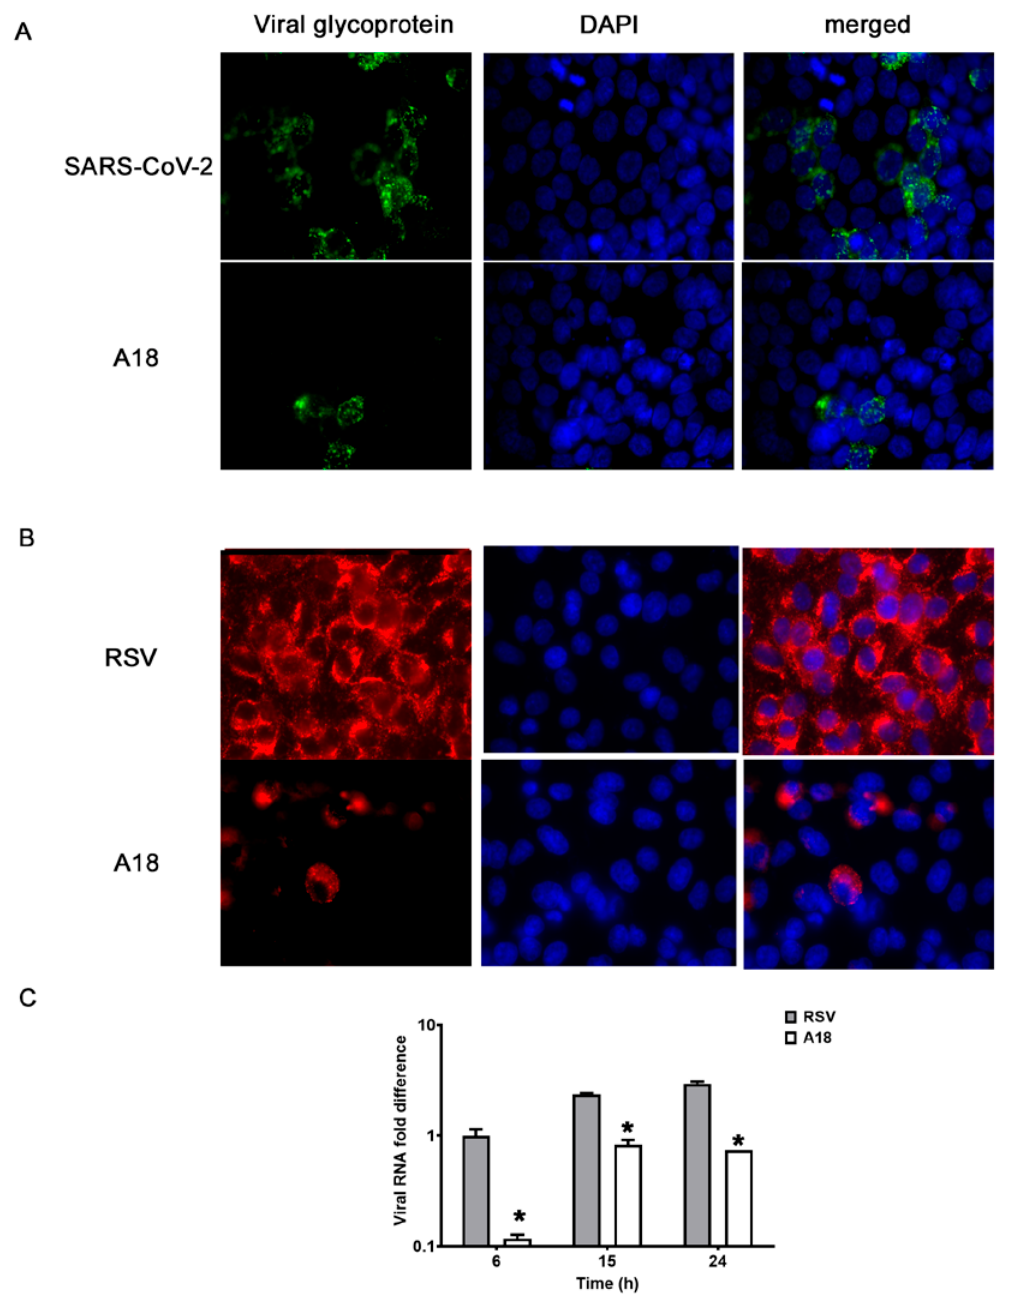
Figure 1. Effect of A18 on virus macromolecular synthesis. ( A , B ) Protein expression. IF staining was performed to detect the intracellular localization of ( A ) SARS-CoV-2 spike glycoprotein in calu-3 cells infected with SARS-CoV-2 (moi = 0.1) and ( B ) RSV gF in A549 cells infected with RSV A2 (moi = 1) and treated or not with A18 (25 mg/mL) at 24 h p.i. Magnification: 400X. ( C ) Viral RNA synthesis. Total cellular RSV RNA was extracted at the indicated times p.i. and viral RNA was quantified by qRT-PCR. The amounts of viral RNA in untreated and treated cells with A18 (25 mg/mL) in A549 cells were calculated in comparison to the content of viral RNA in untreated infected cells at 6 h p.i., defined as 1. Data represent mean ± SD for n = 3 independent experiments, performed in duplicate. * Significantly different from CV ( p -value <